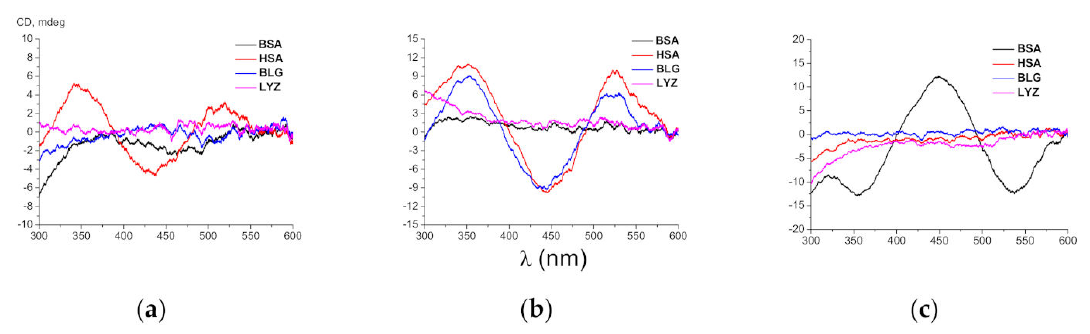
Figure 2. Circular dichroism (CD) spectra of the 2 × 10 –5 M solutions of the clathrochelates 1 ( a ), 2 ( b ), and 3 ( c ) in the presence of 4 × 10 –5 M of bovine (BSA) and human (HSA) serum albumin, lysozyme (LYZ) and beta-lactoglobulin (BLG) in 0.05 M Tris–HCl bu ff er with pH